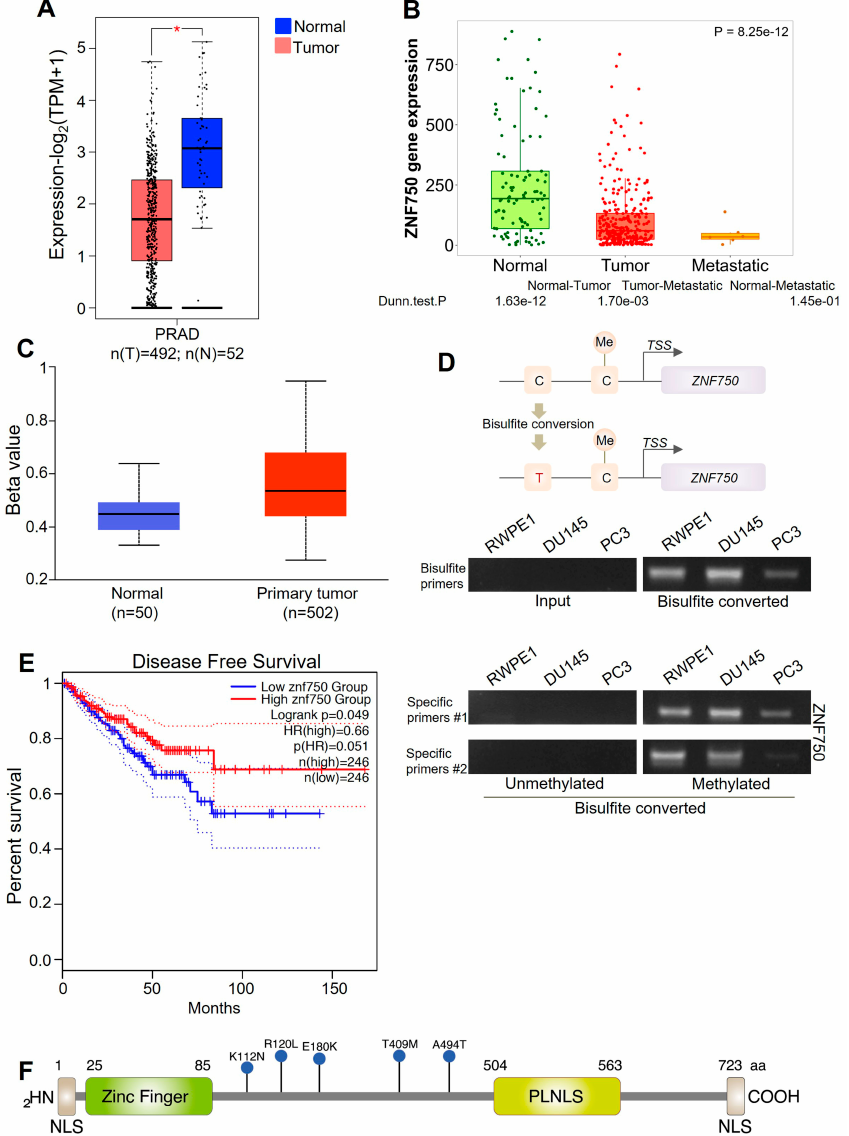
Figure 4. Bioinformatics analysis. ( A ) ZNF750 mRNA expression in tumoral (red, n = 492) and normal (blue, n = 52) tissues, http://gepia.cancer-pku.cn/index.html (accessed on 15 December 2022). * p -value < 0.05 ( B ) Differential expression of ZNF750 mRNA in normal (n = 106), tumor (n = 283), and metastatic tissues (n = 6) in prostate cancer, https://tnmplot.com/analysis/ (accessed on 15 December 2022). ( C ) ZNF750 promoter region is methylated in prostatic acinar adenocarcinomas (normal, n = 50 and primary tumor, n = 502). ( D ) ZNF750 promoter methylation status both in normal and cancer cell lines. ( E ) Patients with low expression of ZNF750 mRNA showed a shorter disease-free survival than patients with high expression of ZNF750 (high n = 246 and low n = 246), http://gepia.cancer-pku.cn/index.html (accessed on 15 December 2022). See Section 4 for details of statistical analysis. ( F ) The most common mutations described in human prostate cancer specimen. Blue lollipops indicate the somatic mutations described in human prostate cancer. The analysis December 2022)). NLS, nuclear